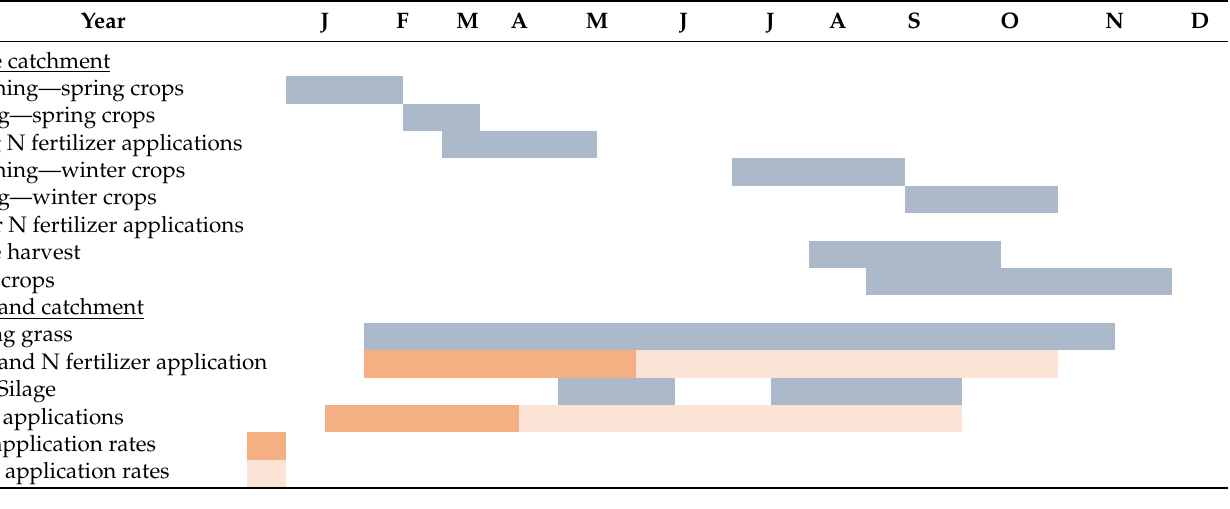
Table 3. Agricultural management timeframes in the arable and grassland